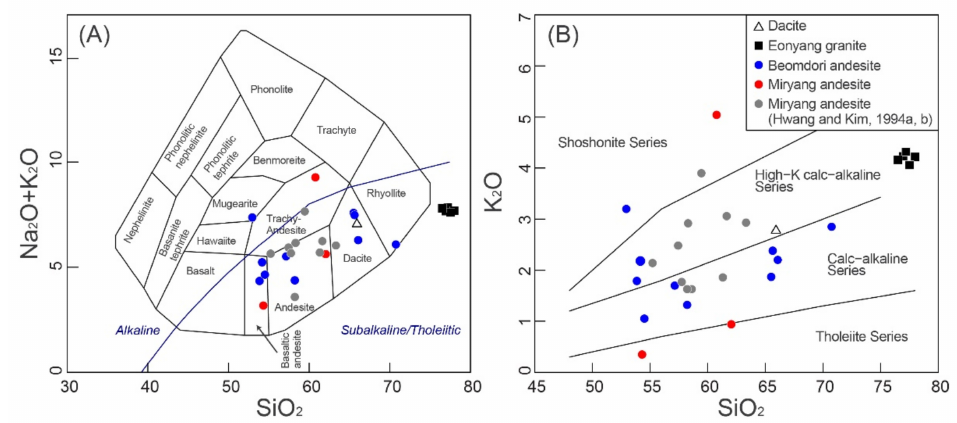
Figure 16. ( A ) Total alkali–silica (TAS) diagram after [23]. ( B ) SiO 2 vs. K 2 O diagram after [24]. The analyzed andesite, granite, and dacite rocks are enriched in large-ion-lithophile- elements (LILEs) and depleted in high-field-strength elements (HFSEs), although the negative troughs for Sr, P, and Ti are more prominent in the Eonyang granite (Figure 17A). In the C1 chondrite normalized REE patterns (Figure 17B), the Eonyang granite shows remarkable negative Eu anomalies (0.17–0.27) compared to those of Miryang andesite (0.53–0.99), Beomdori andesite (0.72–1.01), and dacite (0.87). The analyzed rocks are all